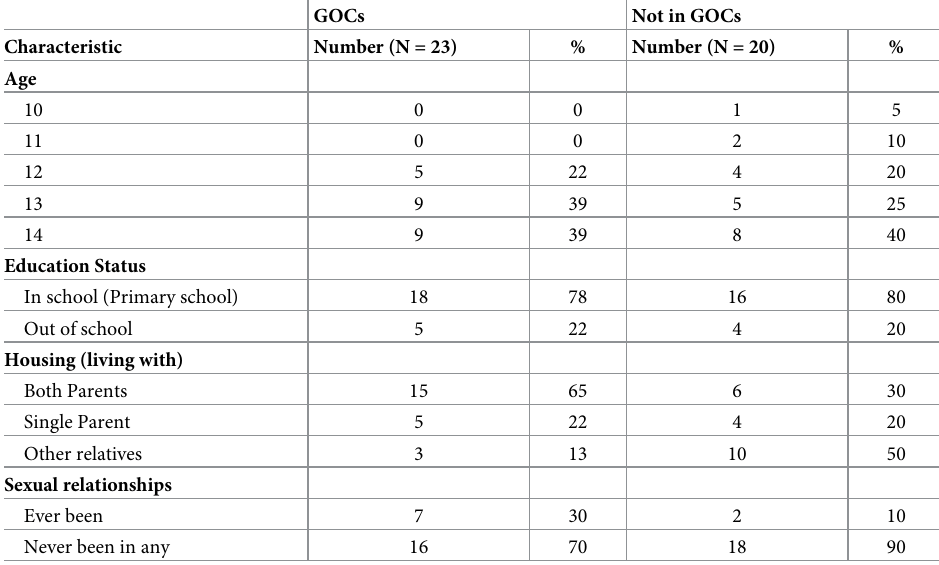
Table 1. Social demographic characteristics of